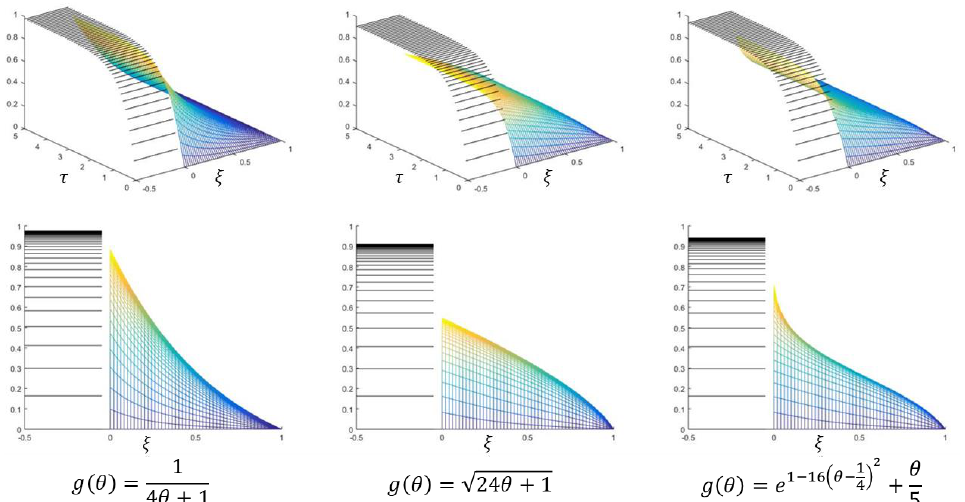
Figure 10. In the top row, the temperature in the tank 𝜓(𝜏) (black) and the temperature in the solid body 𝜃(𝜉, 𝜏) (color) for various thermal conductivity functions 𝑔(𝜃) are shown. In the bottom row, the corresponding temperature profiles at times 𝜏 = 0.1,0.2, … , 5.0 are shown.